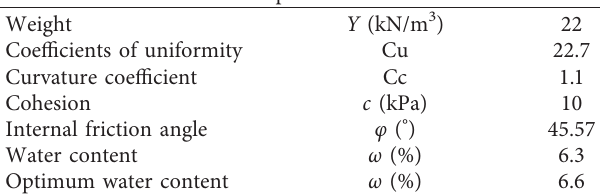
Table 8: The mechanical parameters of undisturbed soil.